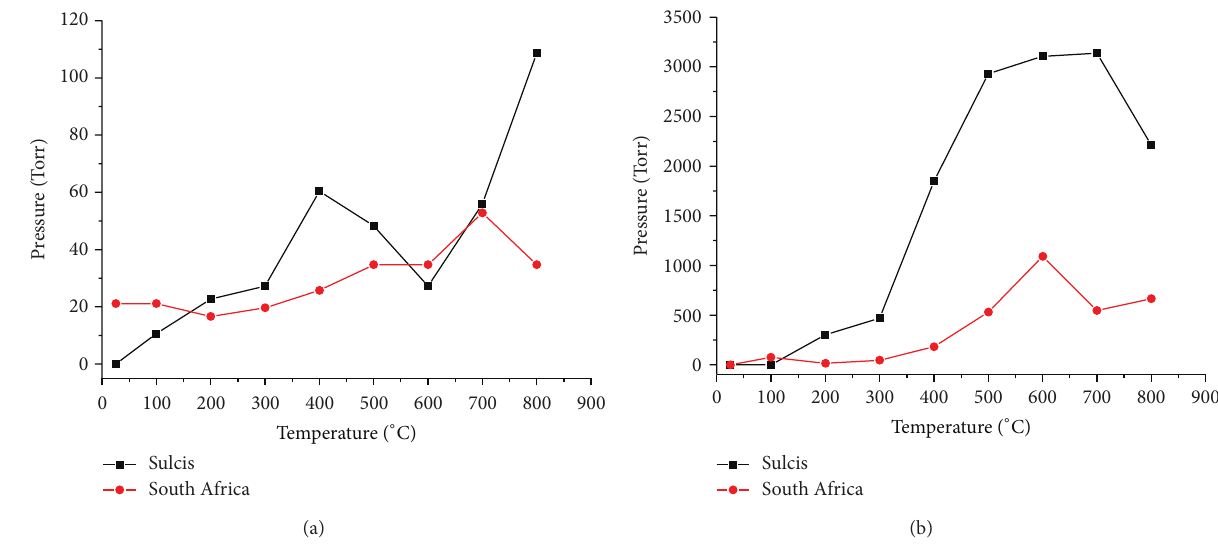
Figure 3: (a) Pressure values against temperature of vapors released by coals and collected in the trap (b) cooled at − 77 ∘ C. (b) Pressure values against temperature of gases released by coals and collected in the trap (c) cooled at − 180 ∘